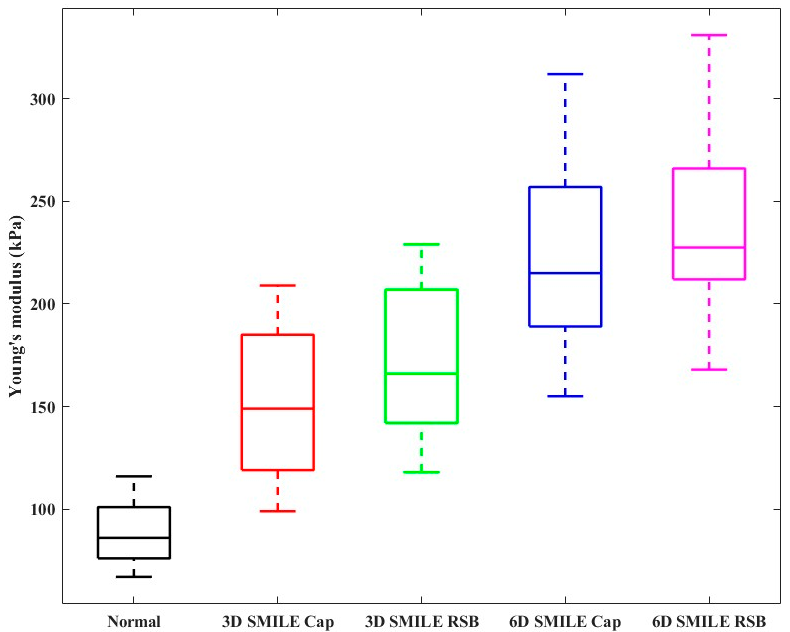
Figure 7. Statistical results of corneal Young’s modulus before SMILE and postoperative Young’s modulus of corneal cap and RSB in 3D and 6D group.